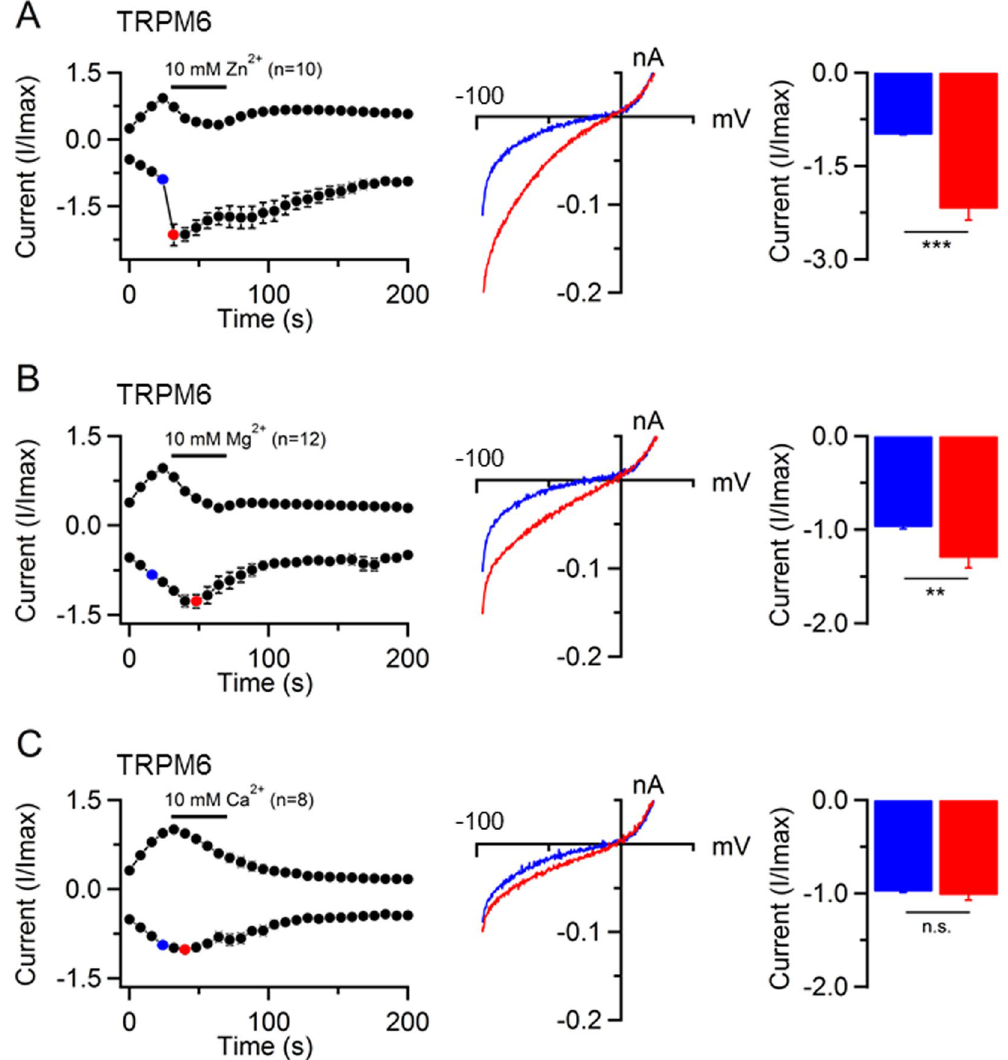
Figure 5. Determination of divalent cations permeability of mTRPM6. Measurements were performed similarly to Fig. 4. ( A ) Left panel: Whole-cell currents were recorded in mTRPM6-transfected HEK 293 cells using the standard [Mg 2 + ] i -free internal solution and standard external saline. When currents started to develop, the cells were exposed to an external solution containing 10 mM Zn 2 + as indicated by a bar. Data are shown as I/Imax ± SEM (Imax value was obtained in a ramp before application of 10 mM Zn 2 + ). Middle panel : Representative I-V relationships of inward currents obtained before (blue) and during (red) application of 10 mM Zn 2 + as indicated in the Left panel . Right panel : Bar graphs of inward currents ( − 80 mV, mean I/ Imax ± SEM) obtained before (blue) and during (red) application of 10 mM Zn 2 + as indicated in the Left panels . ( B , C ) Changes in the inward mTRPM6 currents by exposure of cells to external solutions containing either 10 mM Mg 2 + ( B ) or 10 mM Ca 2 + ( C ). n, number of cells measured; n.s., not significant; ** P < 0.01; *** P < 0.001 (two-tailed